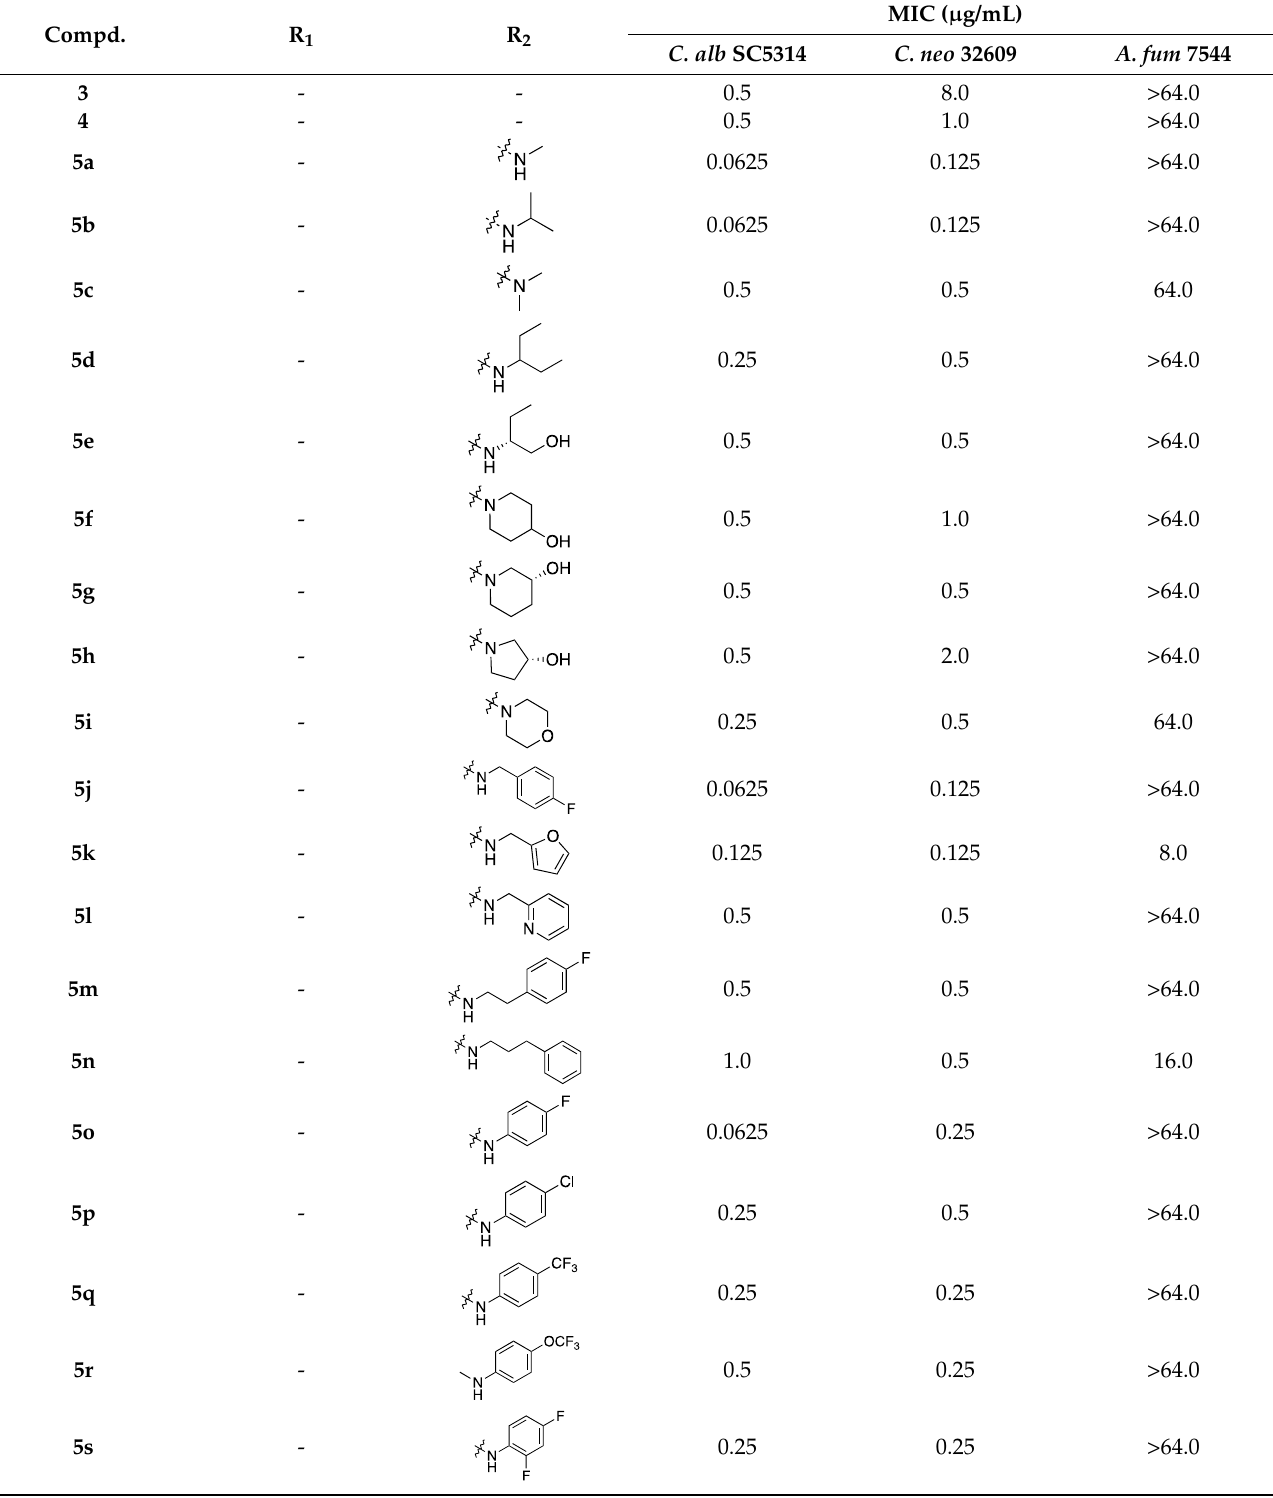
Table 1. In vitro antifungal activity of the target compounds (MIC, μ g/mL). Compd.